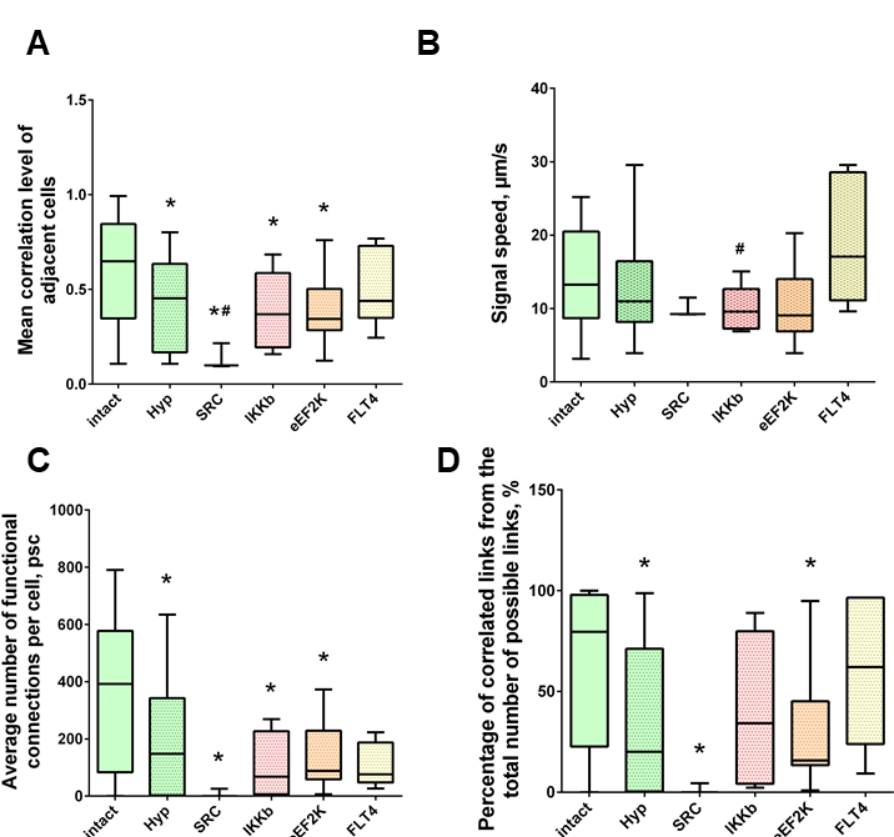
Figure 9. Neuron-glial network activity reorganization in primary hippocampal cultures. ( A ) Mean correlation level of adjacent cells; ( B ) the rate of signal delay between cells; ( C ) average number of functional connections per cell; ( D ) percentage of correlated connections from the total number of possible connections. * versus “Intact”, # versus “Hypoxia”, p < 0.05, Mann-Whitney test.